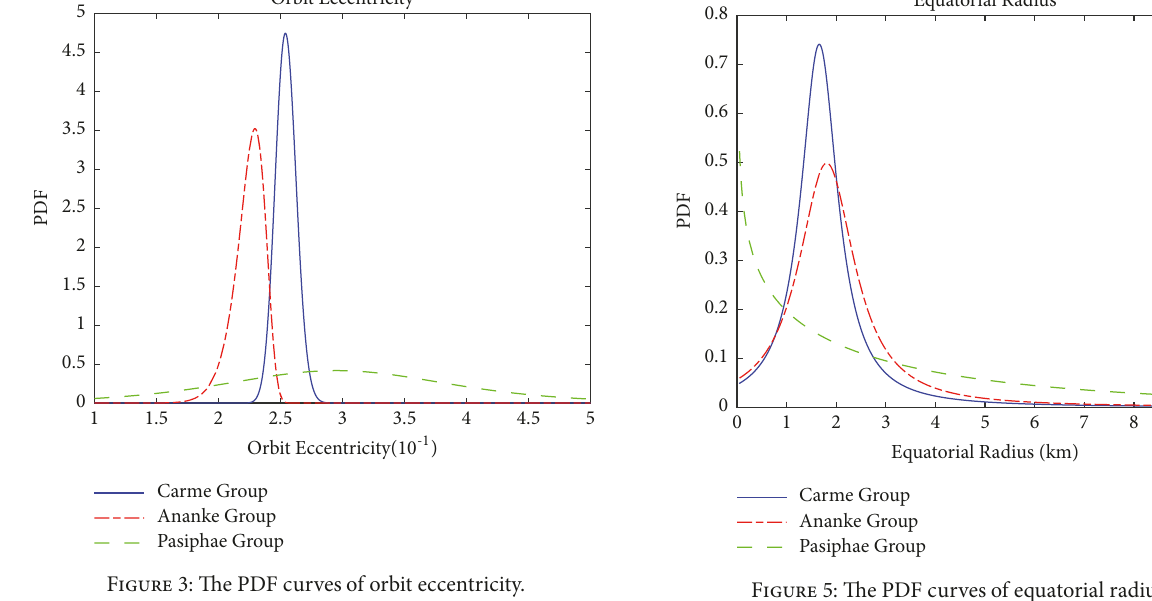
Figure 5: The PDF curves of equatorial radius.